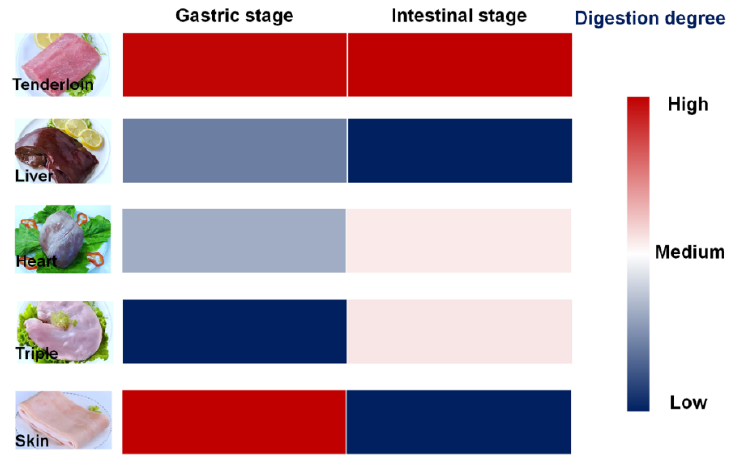
Figure 4. Digestion profiles of cooked edible pork by-products. Supplementary Materials: The following are available online at www.mdpi.com/xxx/s1,Table S1. Liberation of potentially bioactive peptides after the in vitro gastrointestinal digestion. The bioactive probability online (http://distilldeep.ucd.ie/PeptideRanker/), and peptides with the top 5 highest score in the gastrointestinal digest of each sample were illustrated.